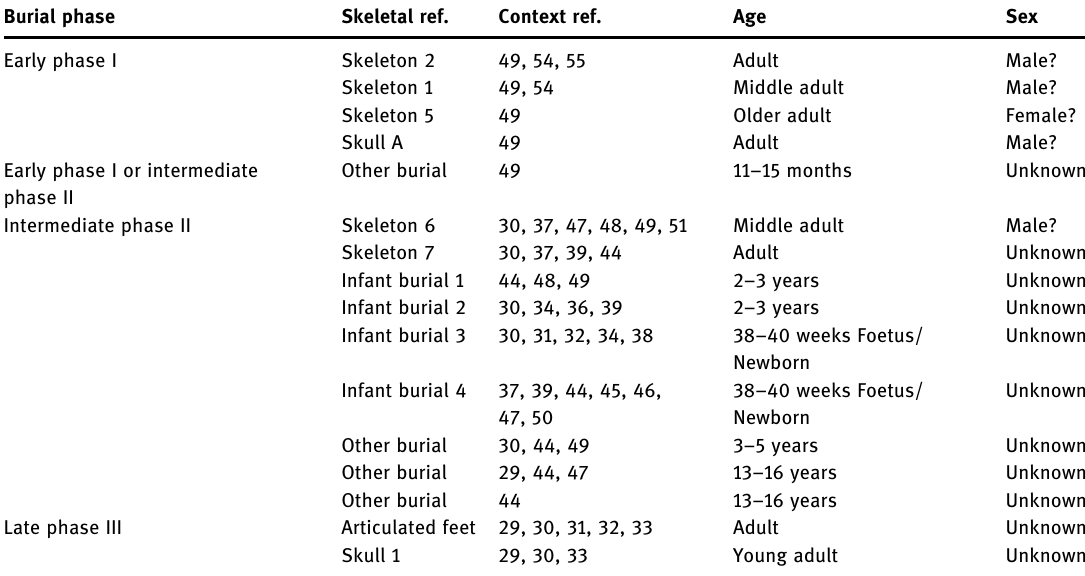
Burial phase Skeletal